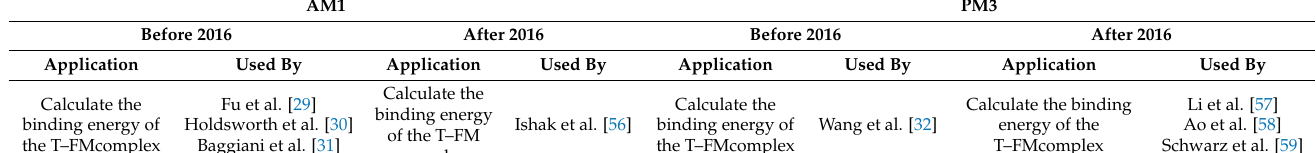
Table 3. Comparison of the semiempirical approach to design molecularly imprinted polymers (MIPs) before and after 2016.